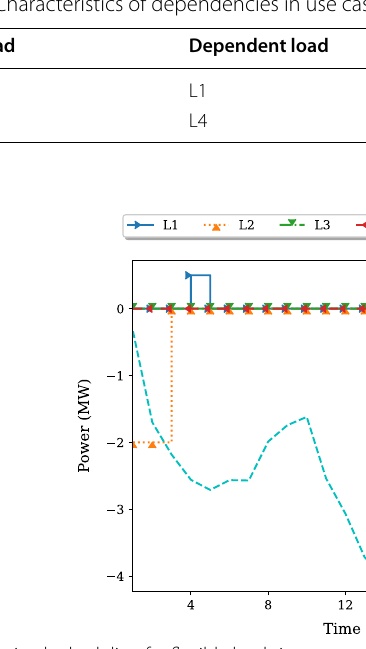
Fig. 5 Optimal scheduling for flexible loads in use case